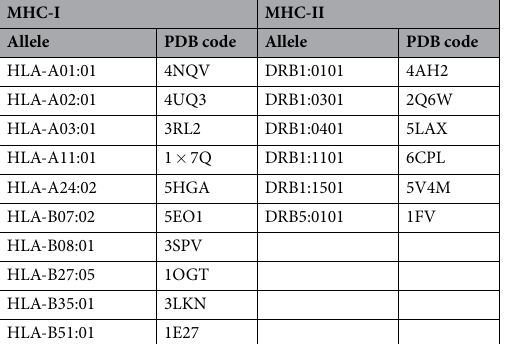
Table 13. MHC allele used for peptide – protein docking.